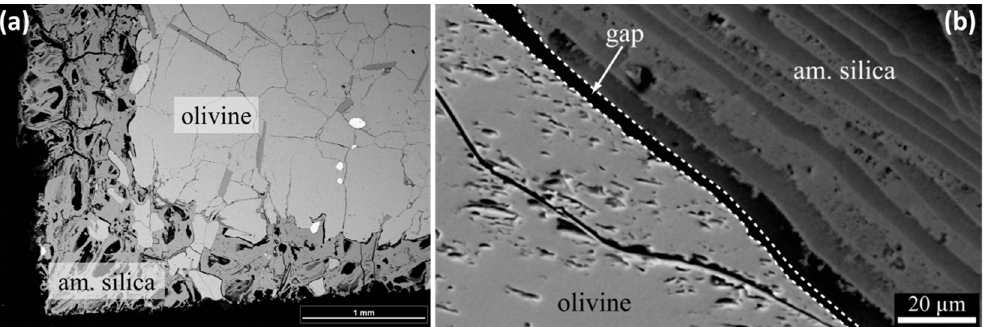
Figure 2. SEM images of ( a ) reacted dunite (olivine-dominated rock) showing the produced amorphous (am) silica rim and ( b ) the interfacial region between olivine and amorphous silica.